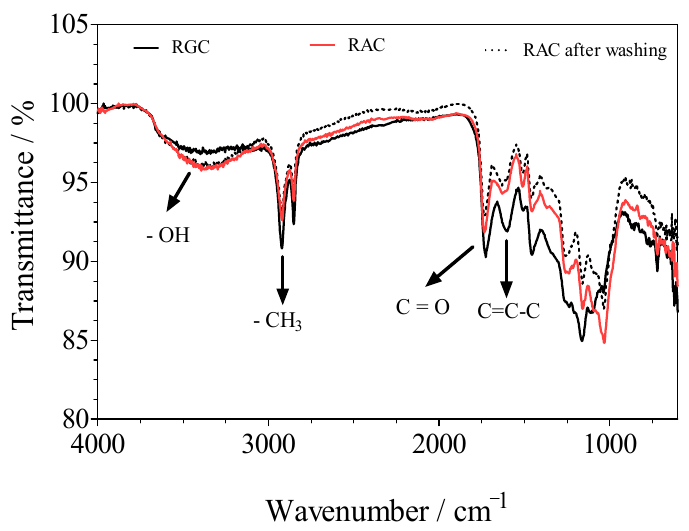
Figure 2. FTIR spectra of the cork granules RAC, RAC after washing and RGC.